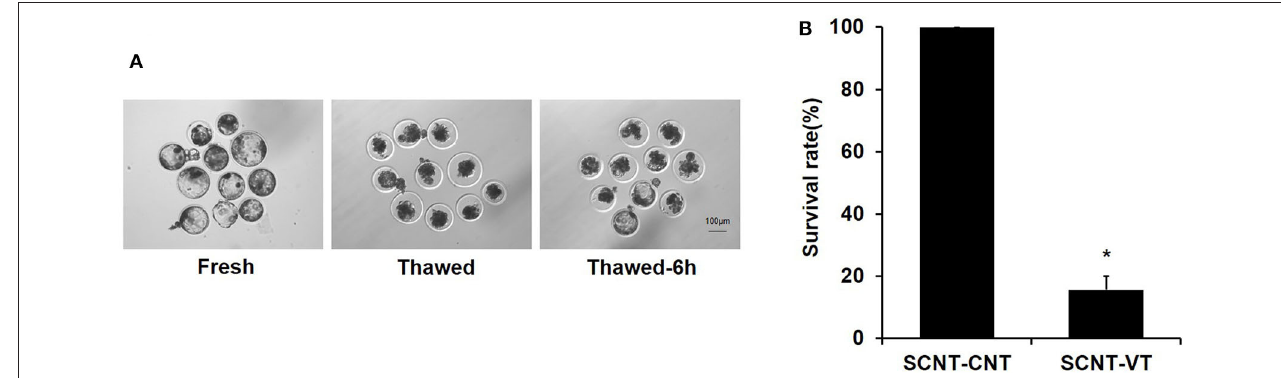
FIGURE 1 | Survival rate of vitrified porcine cloned blastocysts. (A) Cloned blastocysts before cryopreservation, 0 h after thawing, and 6 h after thawing. (B) Survival rate (%) of control and vitrified/thawed porcine cloned blastocysts (thawing for 6 h). Scale bar = 100 µ m. *Indicates significant differences ( p <